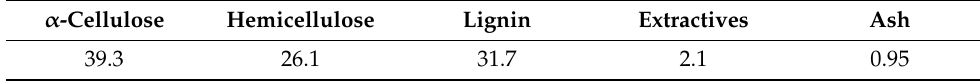
Table 1. Physicochemical characteristics of Pinus densiflora (Unit: %). α -Cellulose